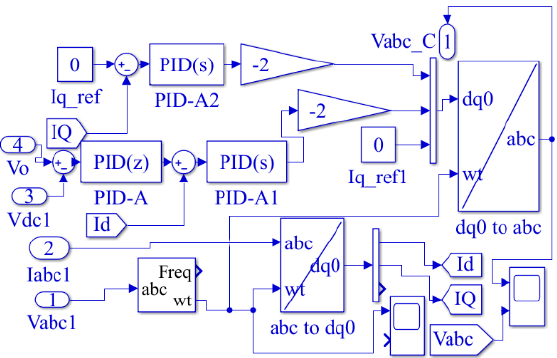
Figure 13. Double closed loop control system.